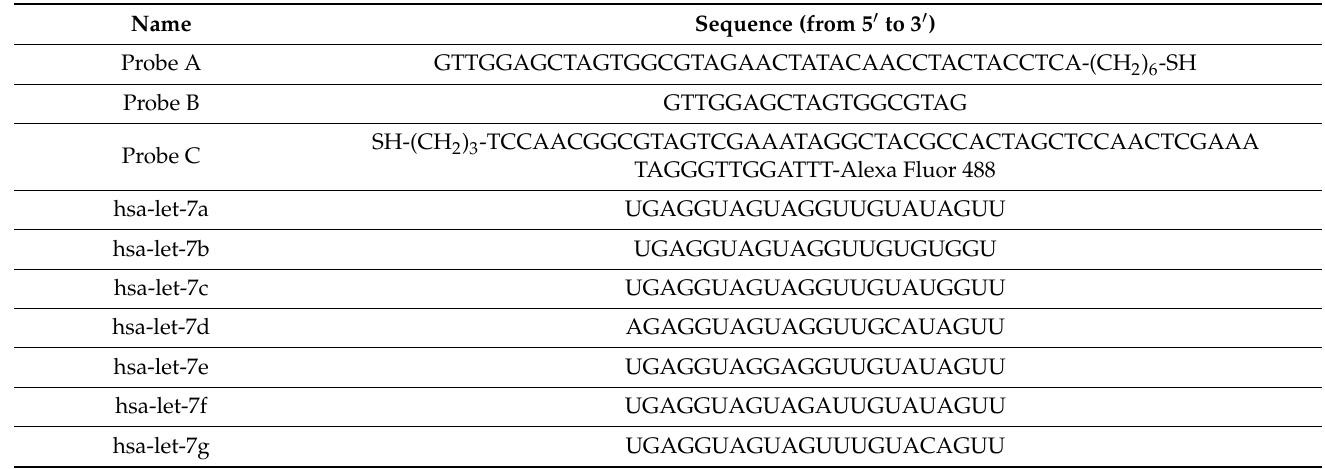
Table 1. DNA and RNA